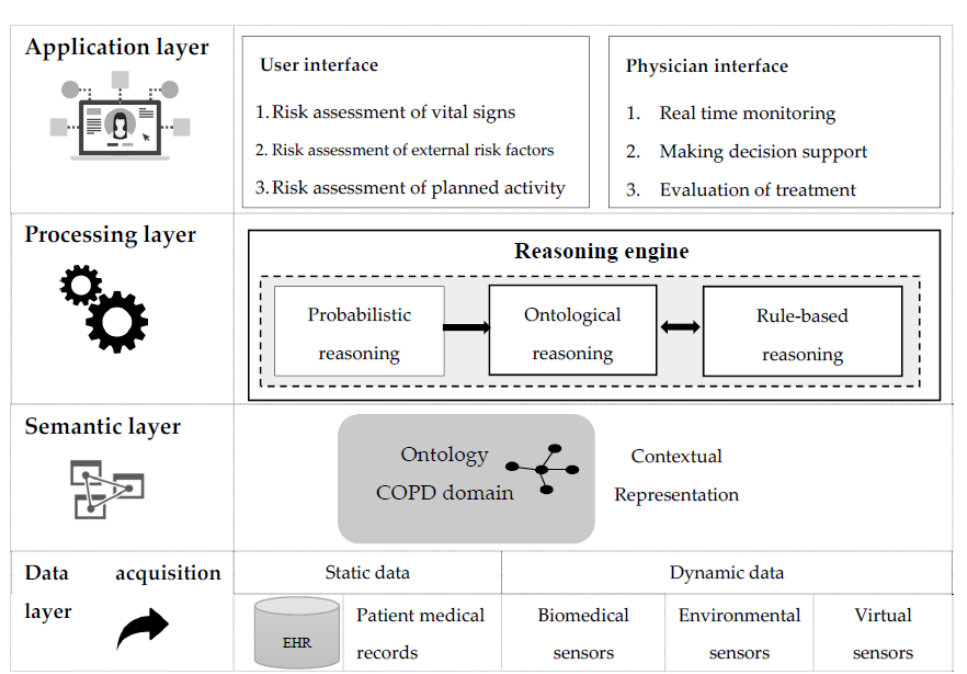
Figure 1. Framework of our COPD decision support system [11].